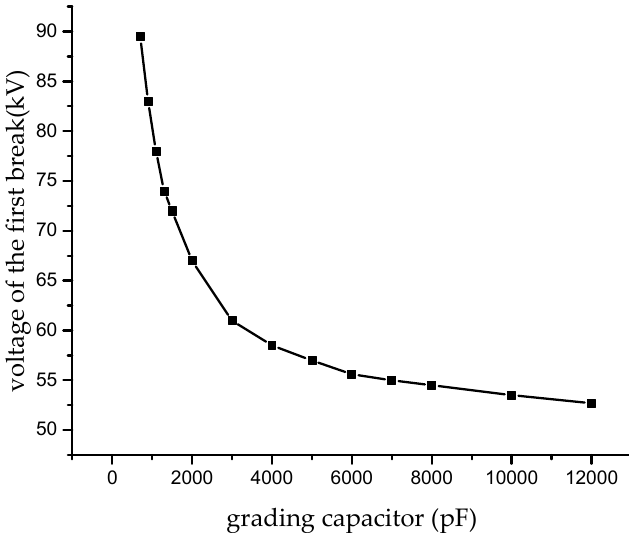
Figure 7. Influence of grading capacitors for the 363 kV VCB.